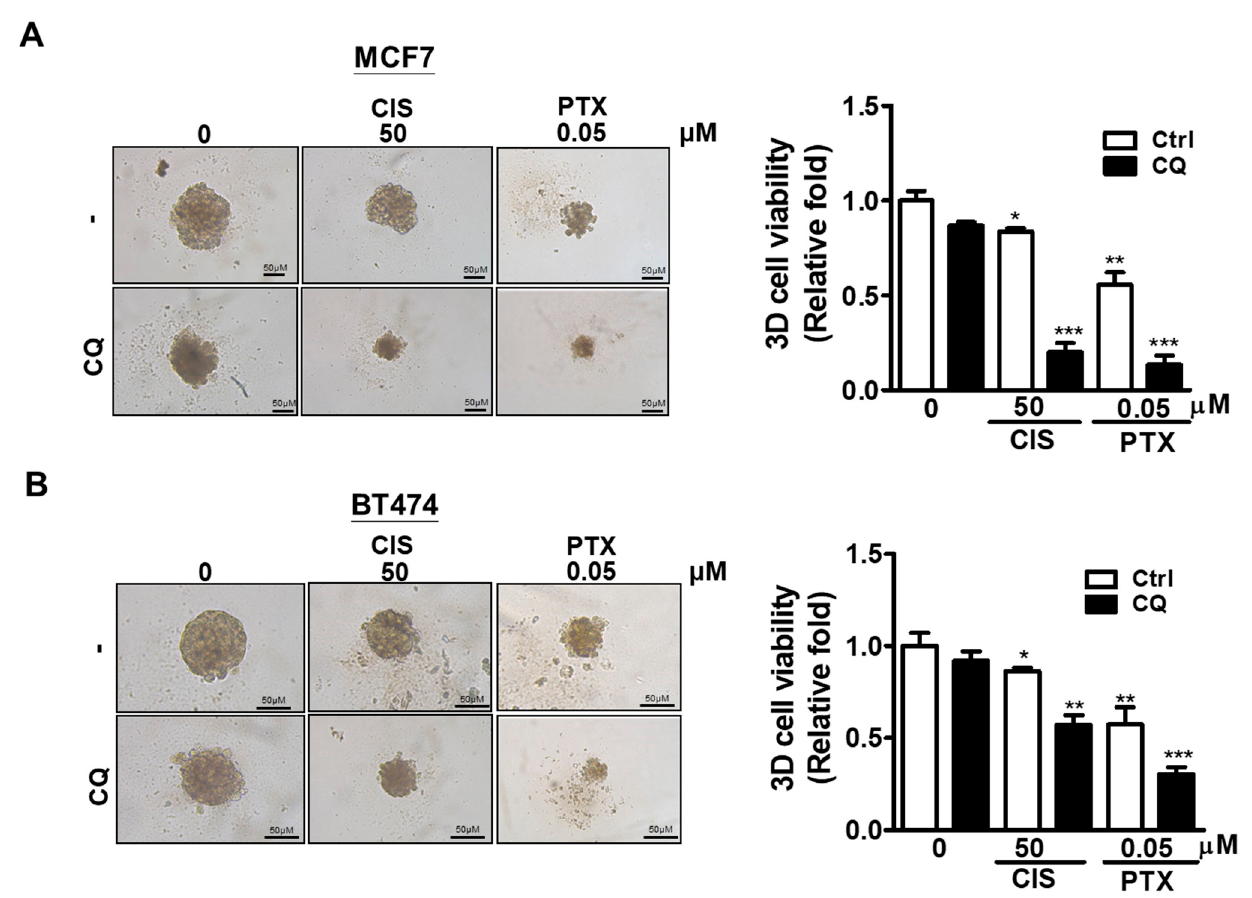
Figure 3. Effects of autophagy inhibition on tumorsphere formation and sphere cell viability in breast cancer cell lines treating cancer drugs. ( A ) MCF7 and ( B ) BT474 cell lines pre-treated with autophagy inhibitor CQ (20 µ M) for 5 h were cultured in a round bottom ultra-low plate for tumorsphere formation. The tumorspheres were then treated with or without cisplatin (CIS, 50 µ M) or paclitaxel (PTX, 0.05 µ M) for 24 h. The sphere morphology and cell viability were detected under light microscopy (100 × magnification) and using the CellTiterGlo 3D system, respectively Results represent the mean of three independent experiments. * p < 0.05; ** p < 0.01; *** p < 0.001.